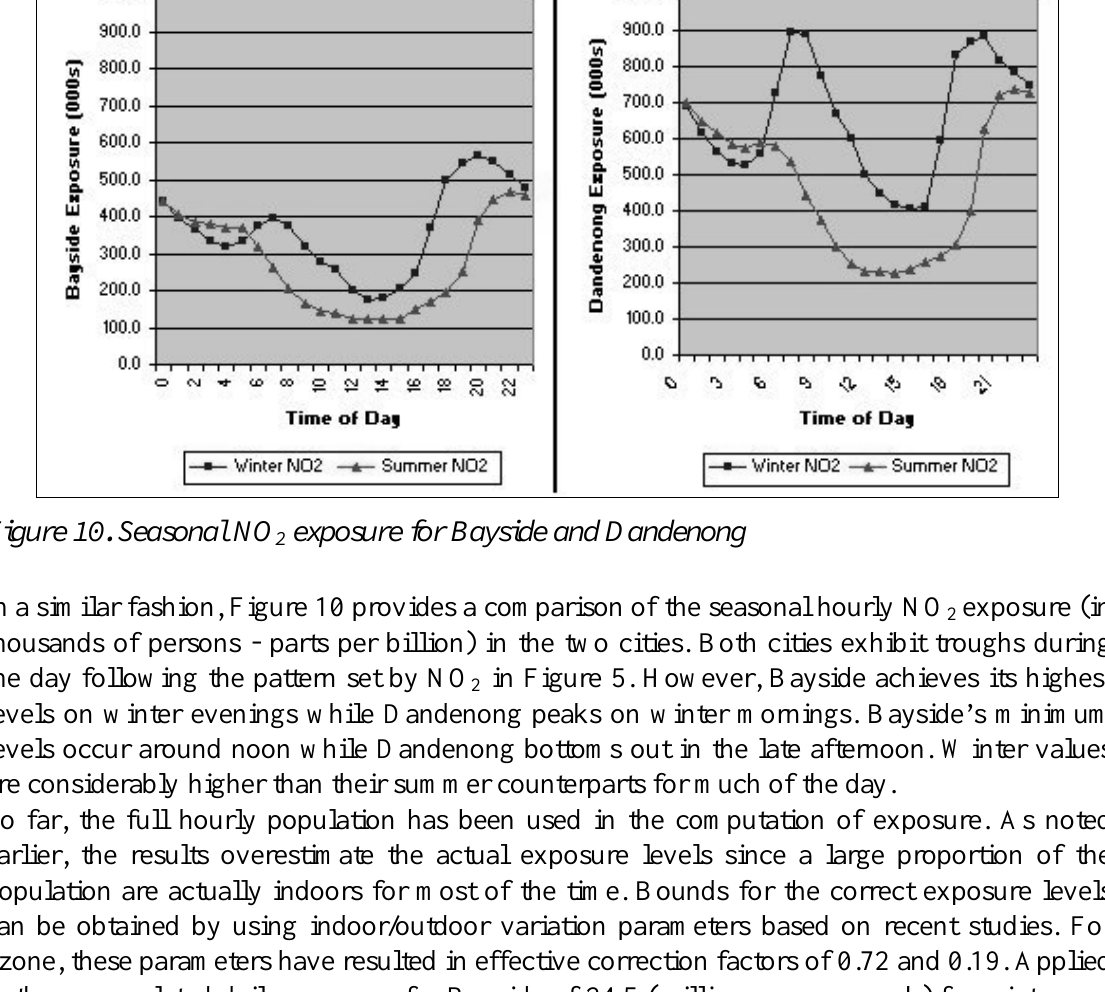
exposure for Bayside and 2